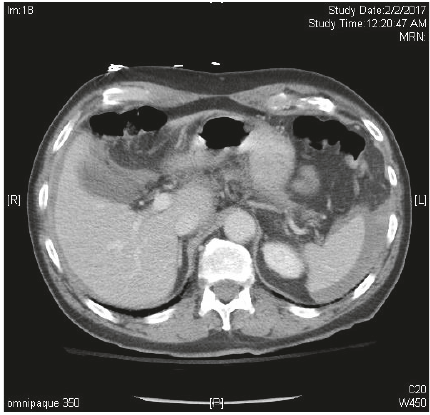
Figure 2: Horizontal CT scan demonstrating hemoperitoneum from iatrogenic spleen injury.